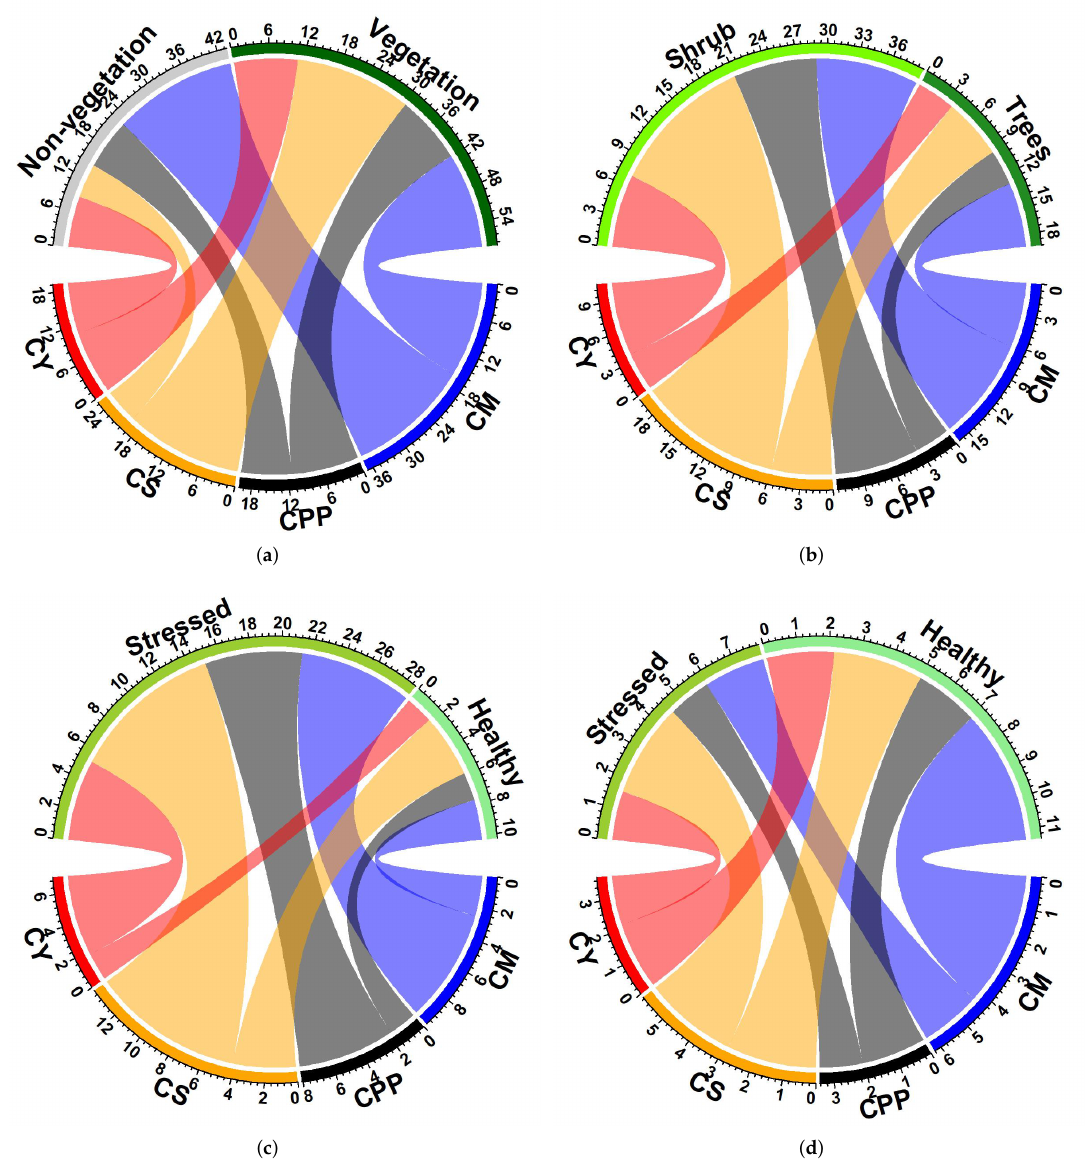
Figure 6. Chord diagram of classification result (in sq. km) of four LGAs of Victoria, Australia, at three levels, namely, ( a ) Level-1 classification; ( b ) Level-2 classification; ( c ) Level-3a classification; and ( d ) Level-3b classification. Note that CY = City of Yarra; CS = City of Stonnington; CPP = City of Port Phillip; and CM = City of